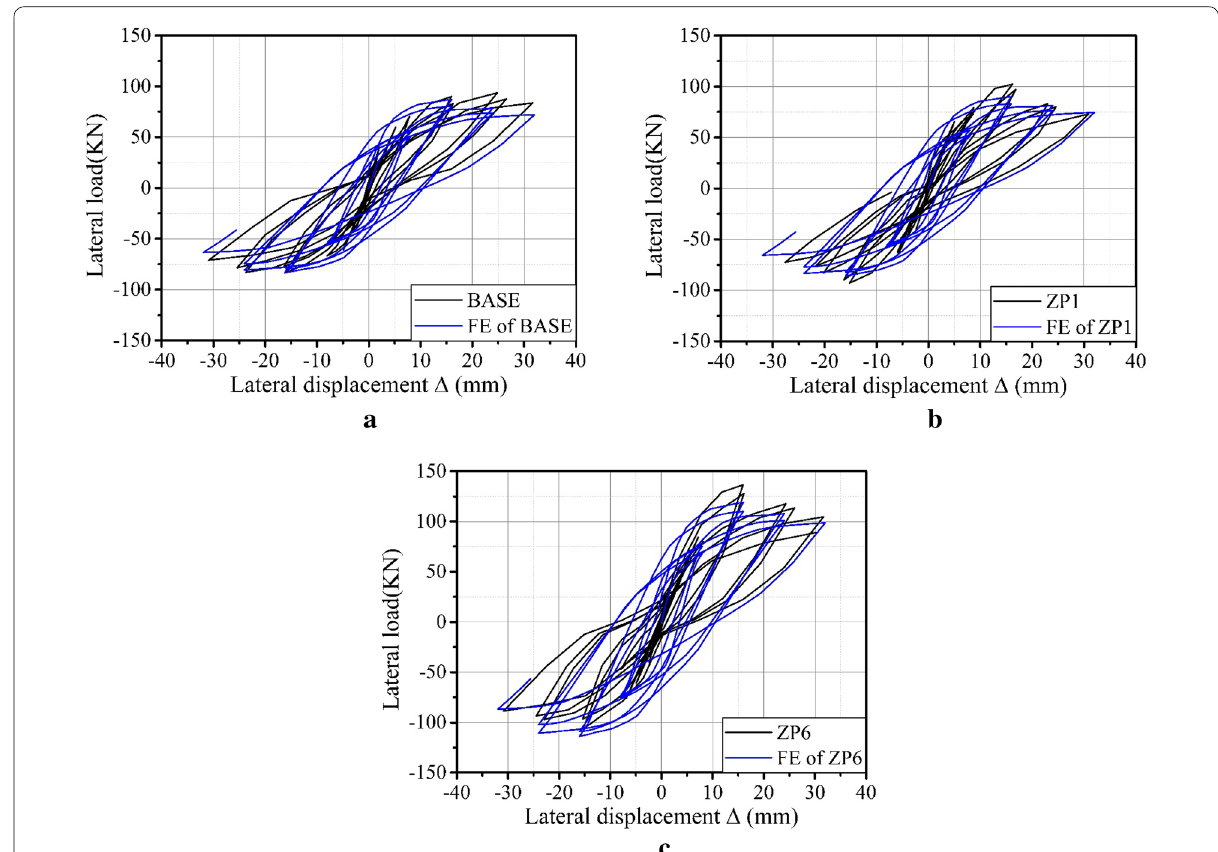
Fig. 14 Load–displacement hysteretic curves of selected columns: a specimen BASE; b specimen ZP1; c specimen ZP6.